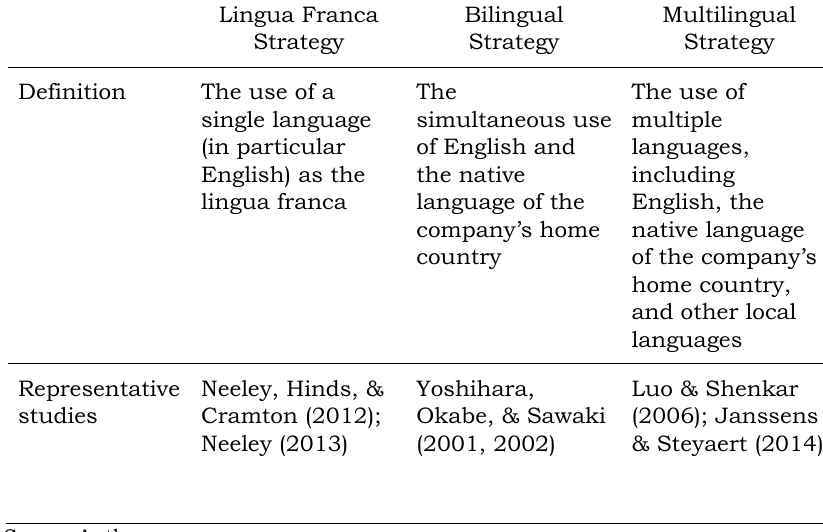
Table 2. Types of language